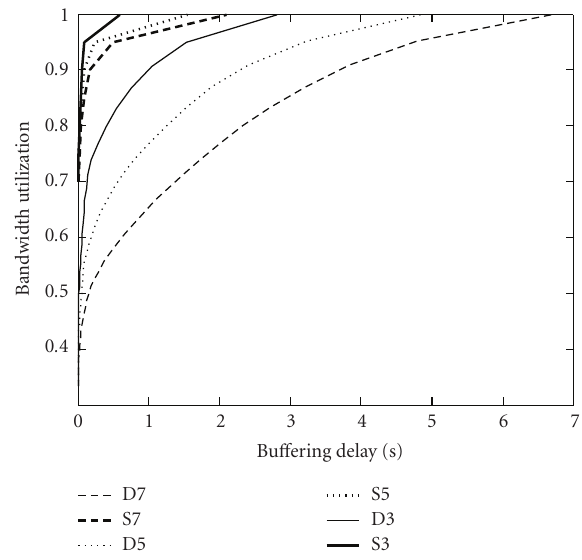
Figure 14: Bandwidth utilization versus bu ff ering delay for Stat- Mux and DetMux.